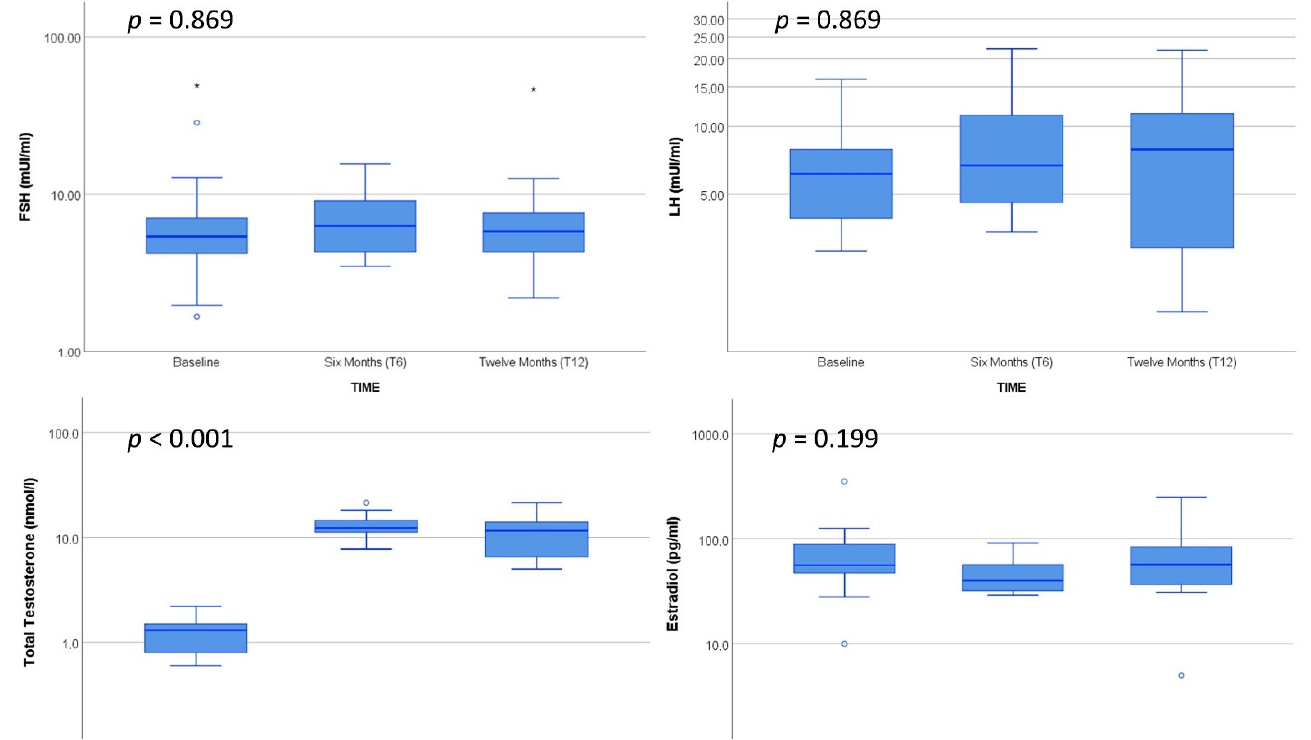
Figure 1. Hormone profile of the recruited subjects at baseline and after 6 mo (T6) and 12 mo (T12) of GAHT. Friedman test. p -values are Bonferroni adjusted.